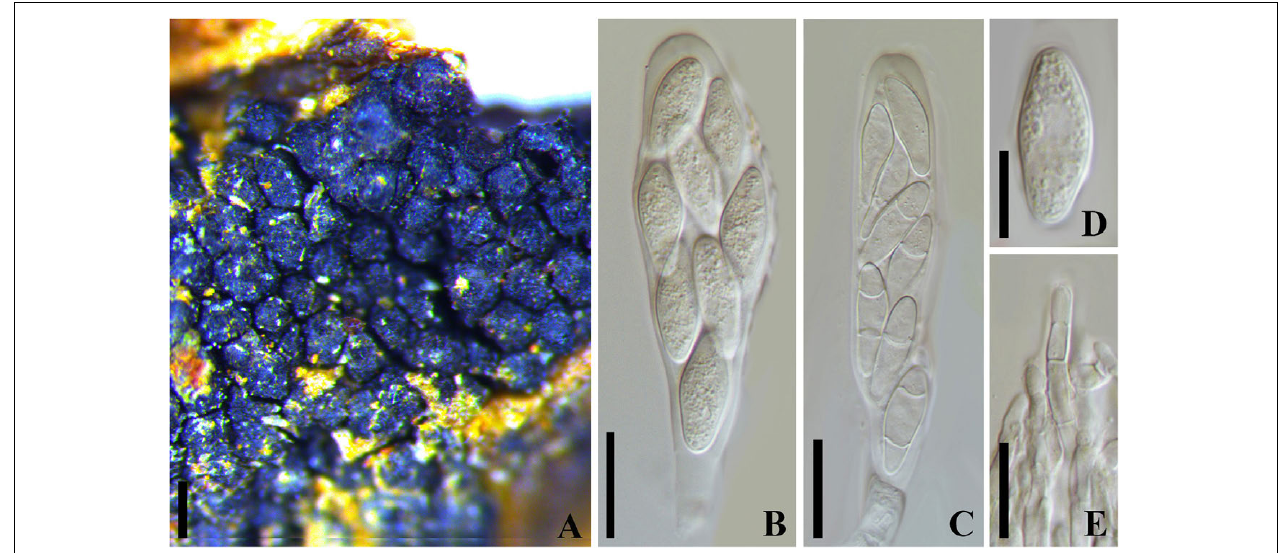
FIGURE 2 | Botryosphaeria dothidea (MICH 13862, isotype of B . berengeriana var. weigeliae ). (A) Botryose clusters of ascomata erumpent through twig epidermis. (B,C) Asci with hyaline aseptate or septate ascospores. (D) Hyaline ascospore. (E) Hyaline, septate, and cellulous pseudoparaphyses. Scale